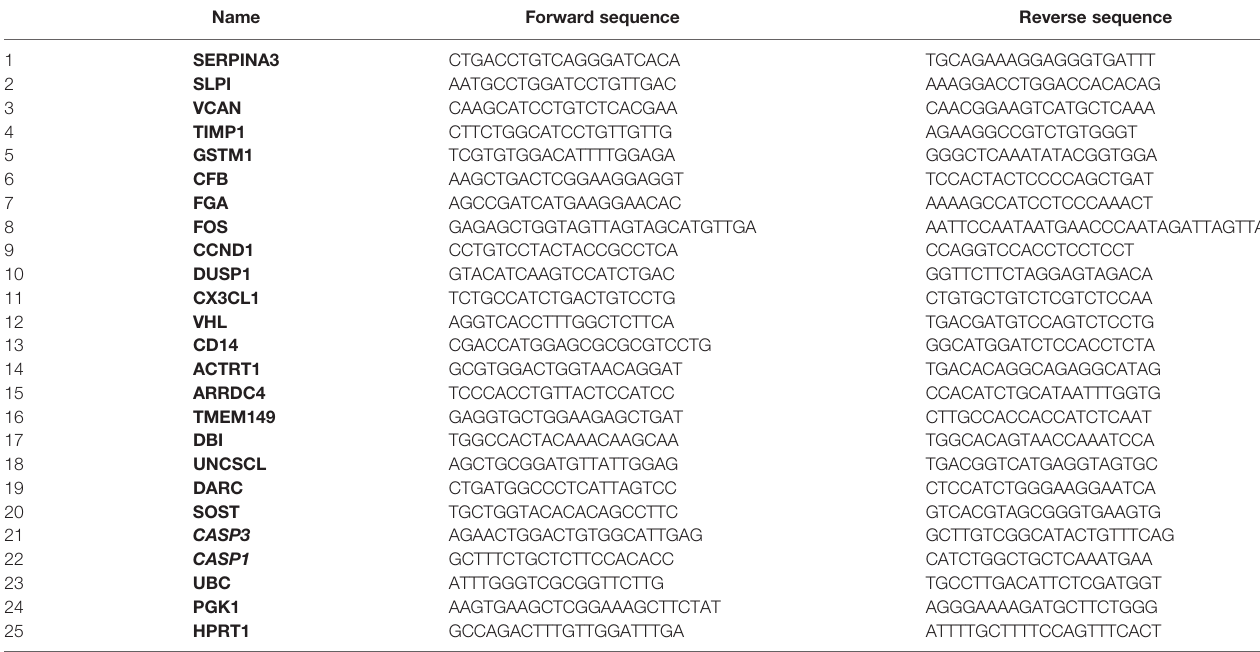
TABLE 1 | 20 highly DEGs selected from microarray analysis for qPCR